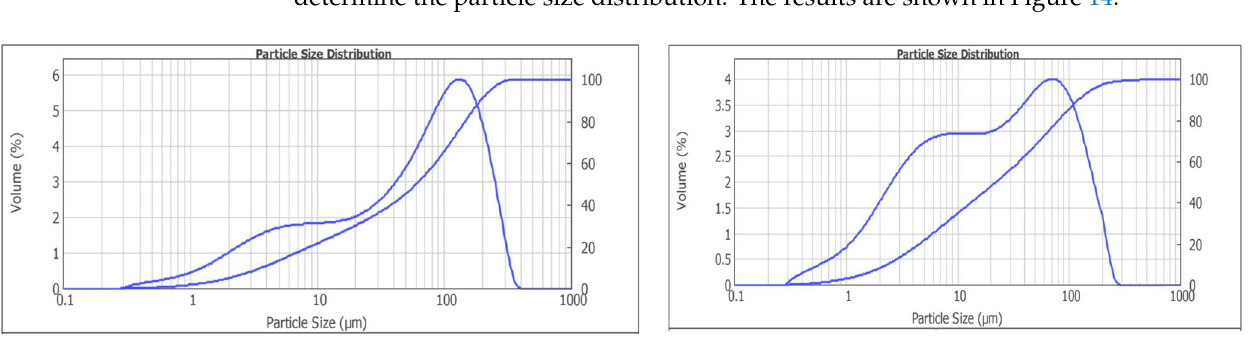
Figure 14. Results of the particle size distribution investigations for the comminution without ( left ) and with aminoacetic acid ( right ). and with aminoacetic acid ( right ).